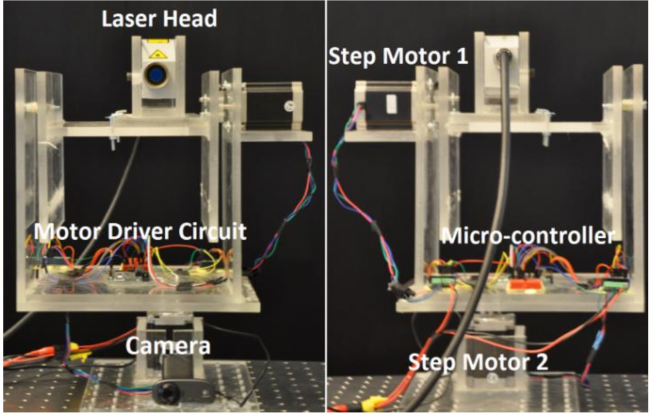
Figure 1. The platform targeting the laser head